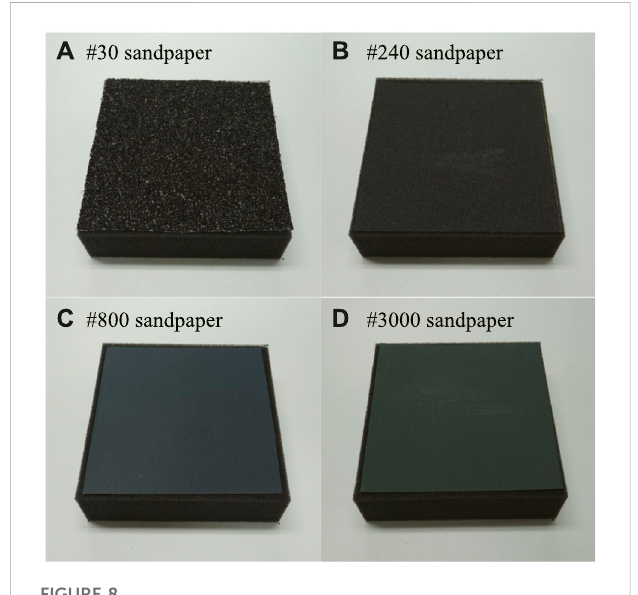
FIGURE 8 Stimuli used in Experiment 2. Four different types of rough and smooth materials. The order of roughness is #30, #240, #800, and #3000 sandpapers.